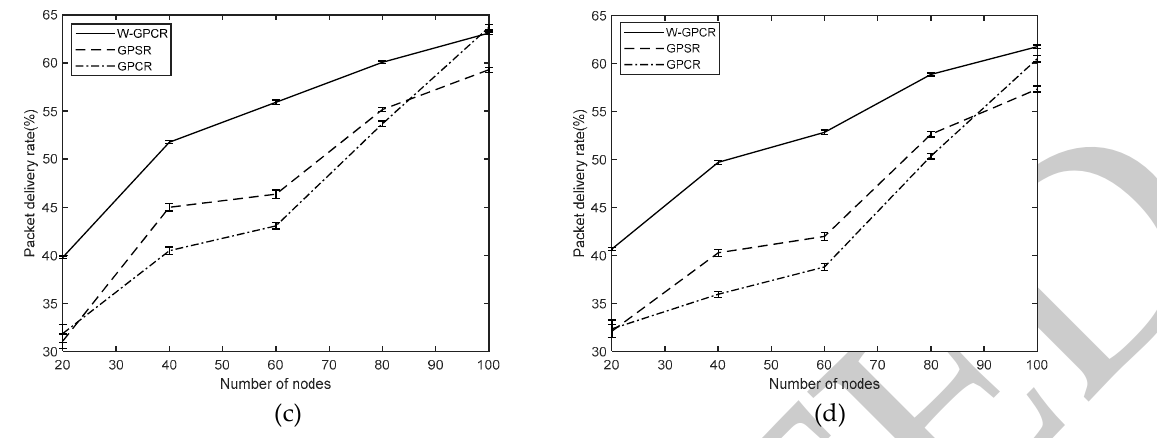
Figure 7. Packet delivery rate for varying the number of nodes and constant bit rate (CBR) connections: ( a ) 5 CBR connections; ( b ) 10 CBR connections; ( c ) 15 CBR connections; ( d ) 20 CBR connections.